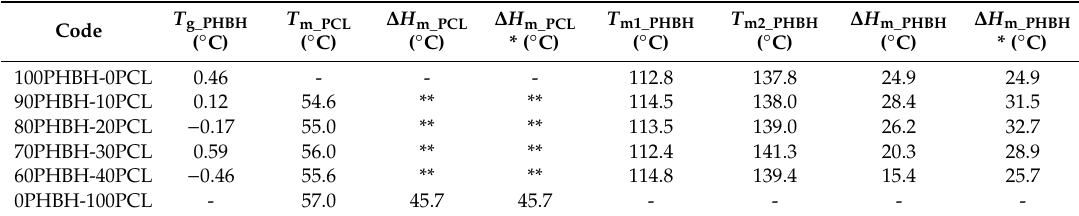
Table 3. Thermal properties of PHBH / PCL binary blends obtained during the 2nd heating cycle after a heating-cooling process to remove thermal